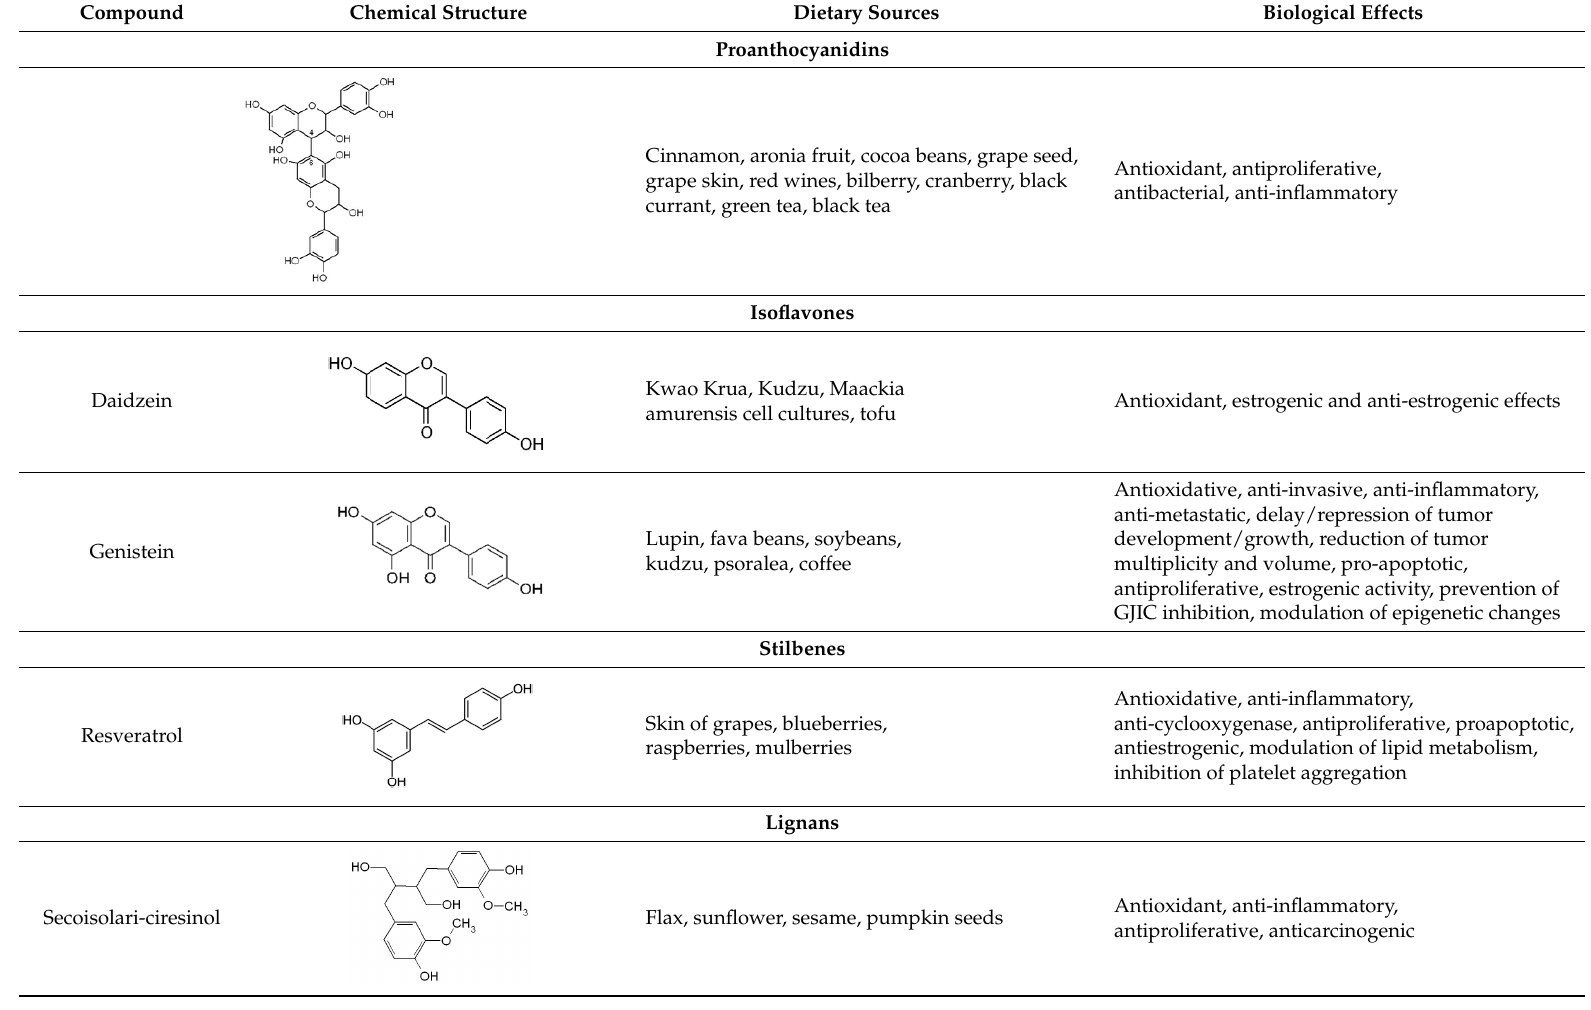
Proanthocyanidins Proanthocyanidins